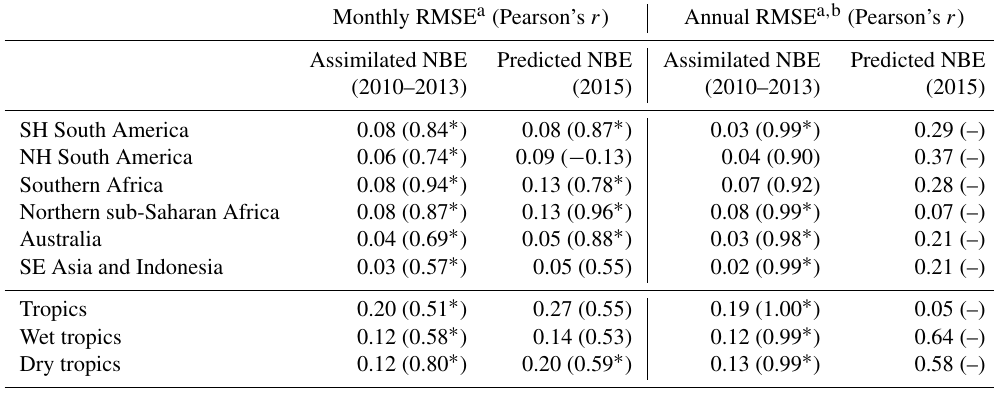
Table 2. CARDAMOM NBE evaluation against assimilated and predicted